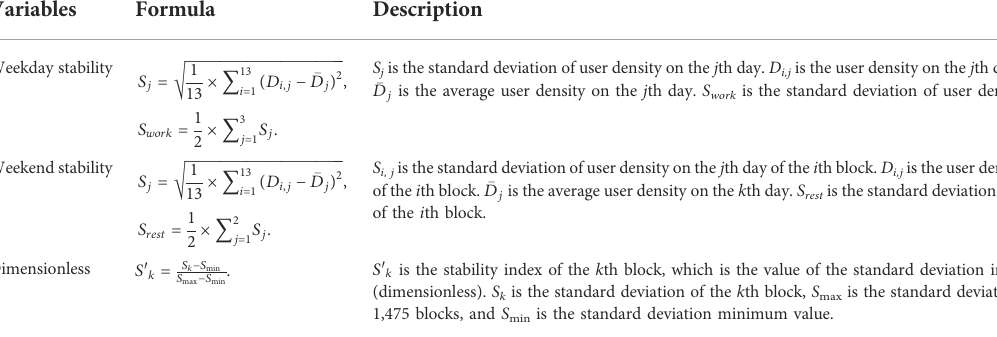
TABLE 3 Vitality stability formulas for weekday and